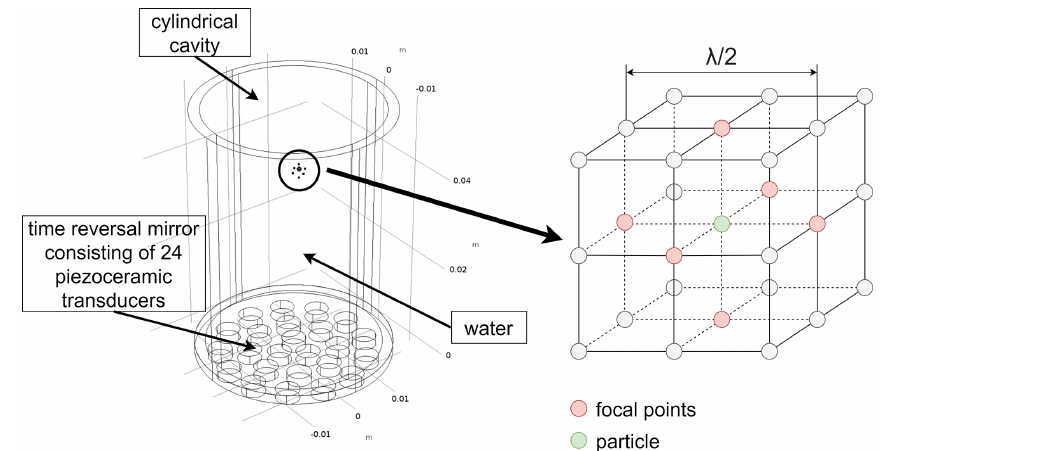
Figure 2. Simulation model of the cylindrical vessel (inner diameter 35.64mm, height 52mm, wall thickness λ/ 2, bottom thickness λ/ 4, wall material PMMA) with a time reversal mirror composed of 24 piezoceramic transducers at the bottom. The integrated focal points are arranged around an example particle in the shape of the bottle